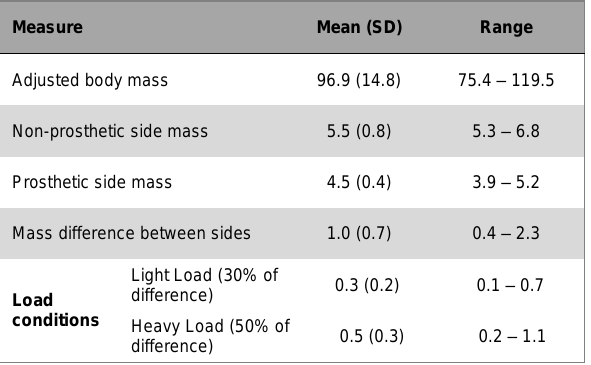
Table 2: Estimated mass properties of the prosthetic and intact side.